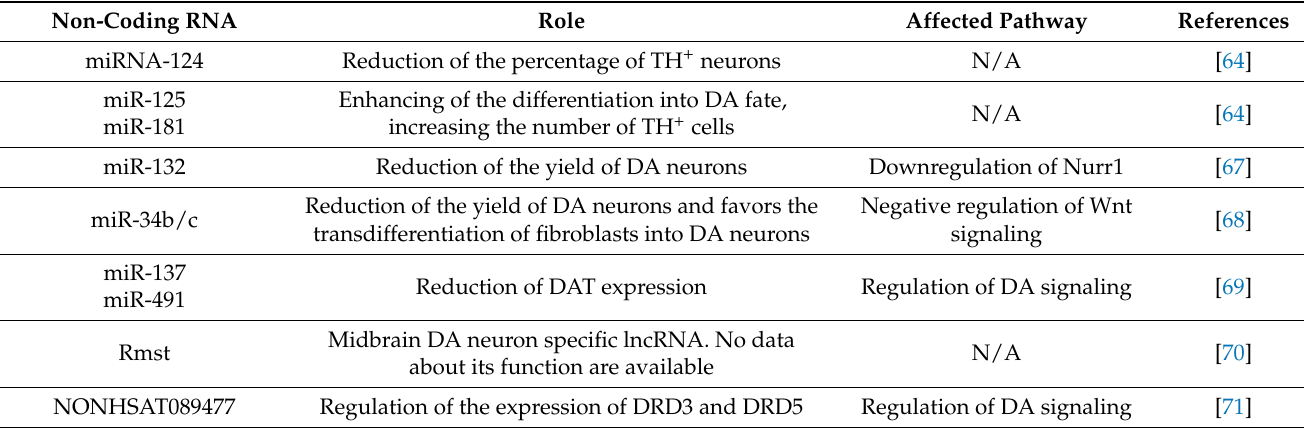
Table 3. Schematic overview of miRNAs and lncRNAs involved in the differentiation and maintenance of DA neurons. Non-Coding